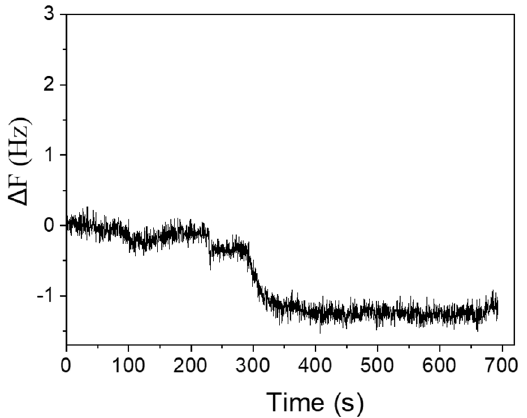
Figure 10. The variation in Δ F with time upon addition of Q[7] (0.1 mmol·L − 1 ).